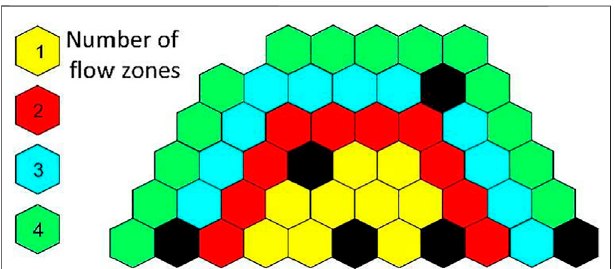
FIGURE 4 | Flow zoning results of half